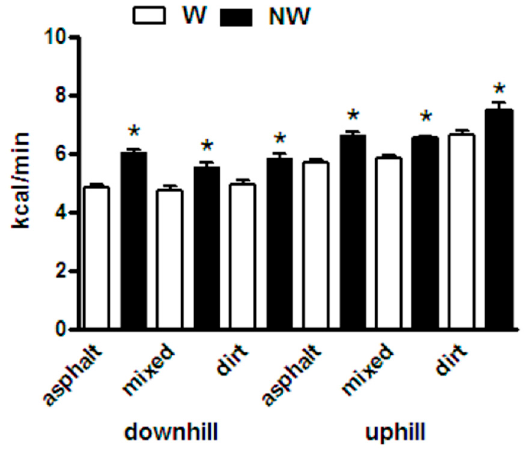
Figure 2. Average of the Energy Consumption Estimation for the “mixed terrain path”, “the asphalt path” and the “off-road path”. If the grand means (mean of the means) were compared, the cost of locomotion was 19.5% higher with poles (nordic walking NW, 6.57 ± 0.54 kcal min − 1 ) than without poles (ordinary walking W, 5.49 ± 0.47 kcal min − 1